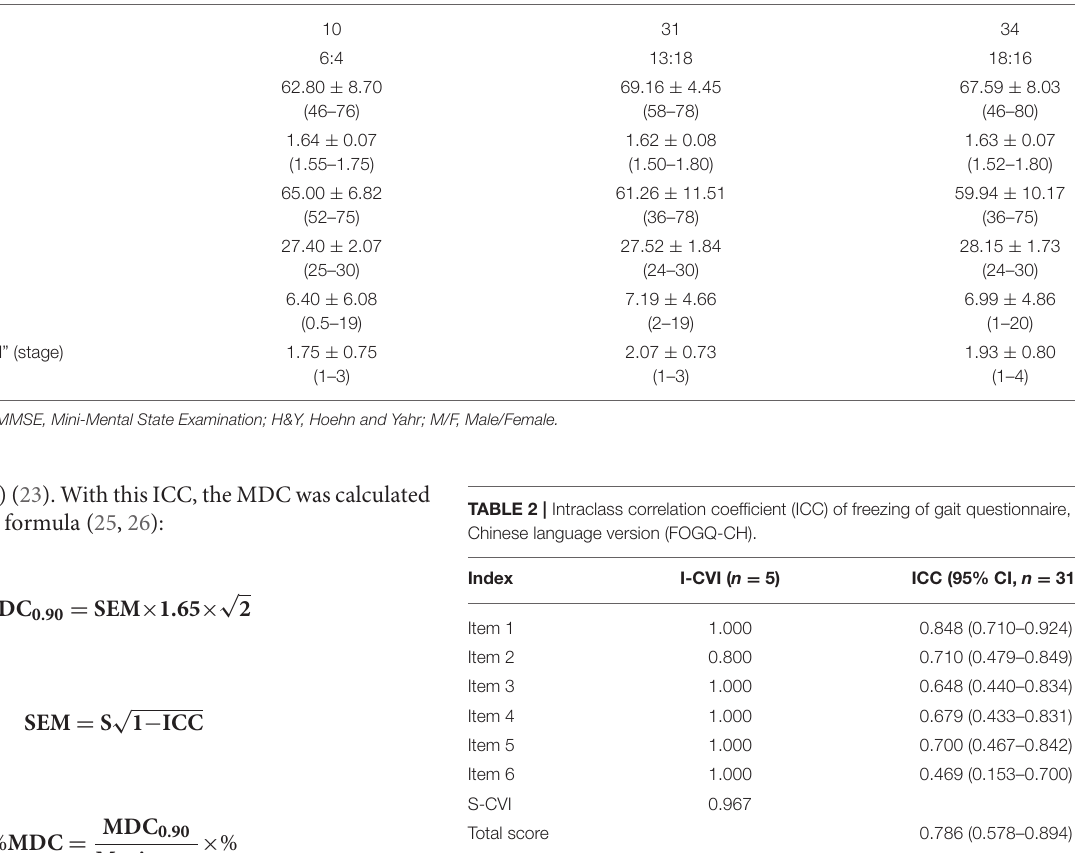
SD (minimum-maximum). ± Pre-test study